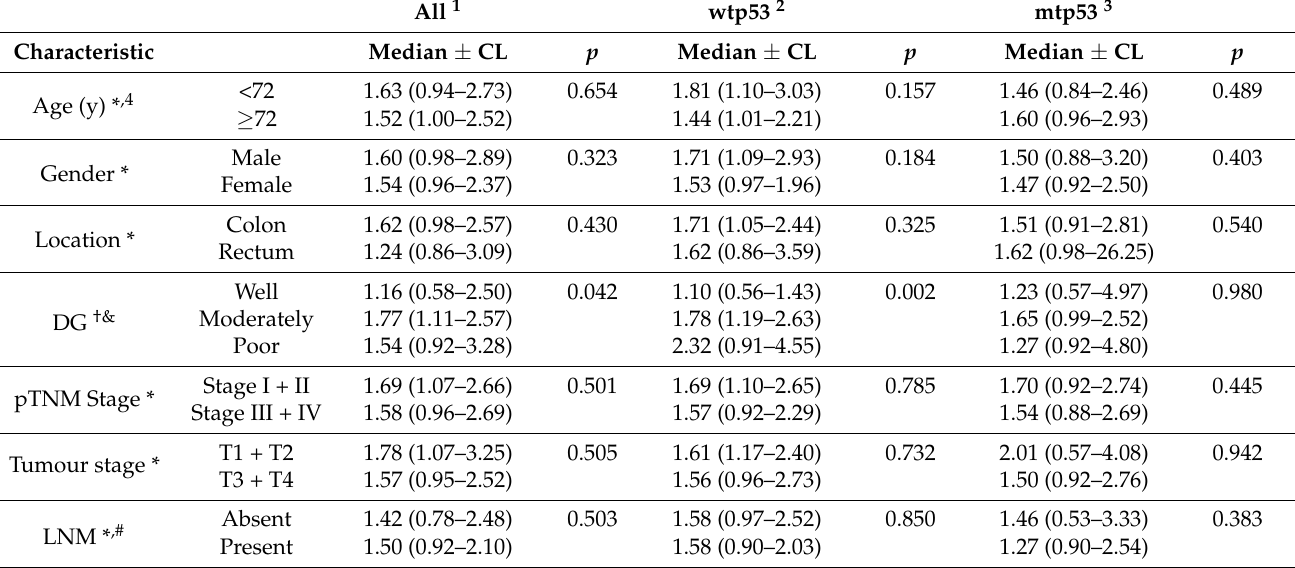
Table 1. Relationship between PARP-1 expression and clinicopathological characteristics of patients at different status of p53 .